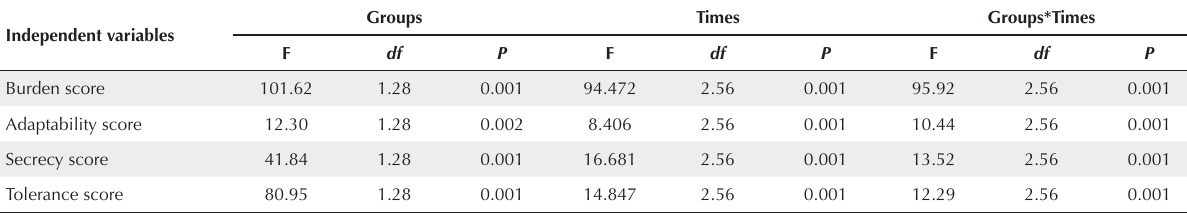
Table 4. Repeated measures ANOVA results: effects of groups (control, experimental), times (pre-test, post-test, after follow-up), and their interaction groups*times independent variables Groups Times Groups*Times Independent variables